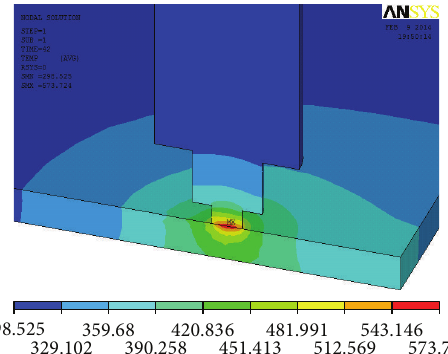
Figure 6: Temperature contour gradient of the whole pin penetra- tion stage. (Temperature is in Kelvin). 𝑥 1 = 30 mm.